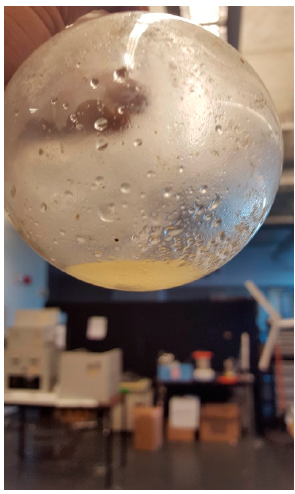
Figure 13. 7 mL of oil sample from 15 g LDPE.